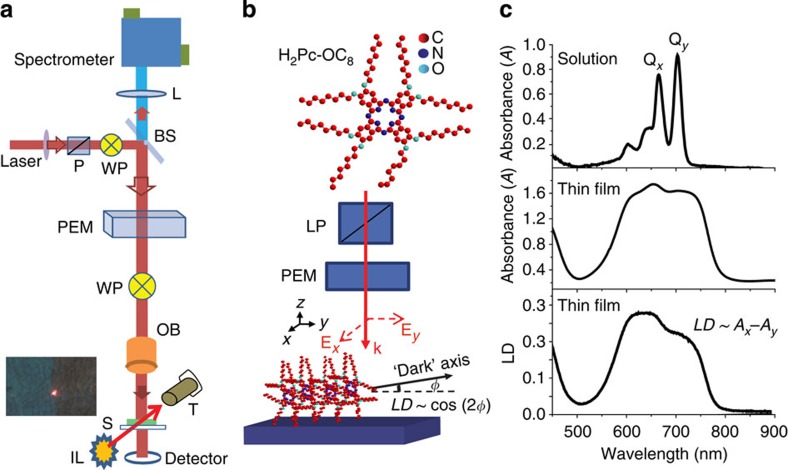
Linear dichroism (LD) and molecular ordering.(a) Schematics of the LD/PL microscopy experiment employed to study the relative orientation of crystalline grains in the H2Pc-OC8 thin films. The LD image is acquired in transmission geometry by scanning a polarization-modulated focused laser beam onto the sample surface while spatially- and polarization-resolved PL spectra are recorded in backscattering geometry, after removing the piezoelectric modulator and waveplate from the setup. BS, beam splitter; IL, illumination lamp; L, singlet lens; OB, objective lens; P, linear polarizer; PEM, piezoelectric modulator; S, sample; T, long working distance observation telescope; WP, half-wave plate. (b) Molecular structure of H2Pc-OC8 and the orientation of light polarization with respect to the ‘edge-on' molecular stacking. Light polarized perpendicular to the stacking (‘dark') axis is predominantly absorbed. (c) Typical absorbance (A ∼αd) and linear dichroism (LD ∼Ax−Ay) spectra from an H2Pc-OC8 crystalline film deposited using the pen-writing technique (a reference spectrum of the same molecule in solution is shown for comparison).